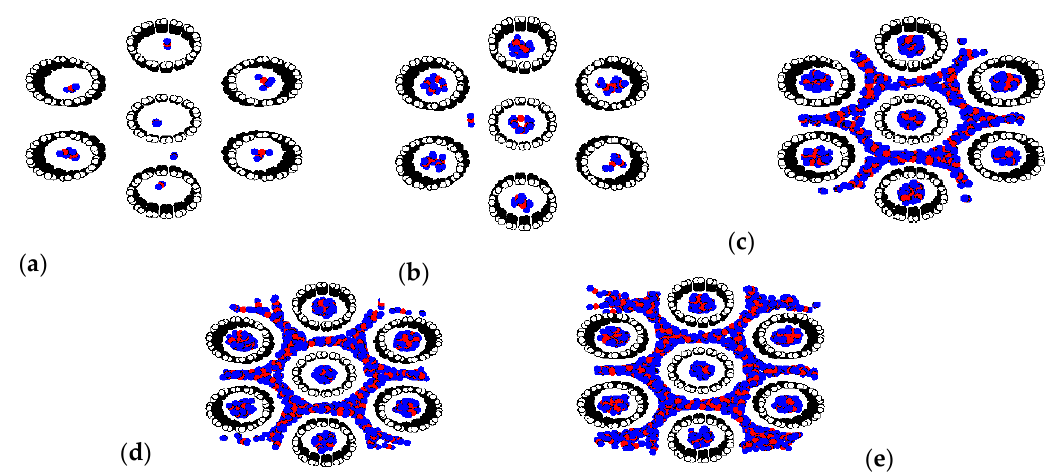
Figure 14. Snapshots of CO 2 adsorption at various pressures: p = 0.3 ( a ), 1 ( b ), 900 ( c ), 8000 ( d ) and 90,000 Pa ( e ) in 10.8 Ǻ tubes at 273 K and TWD of 7 Å .